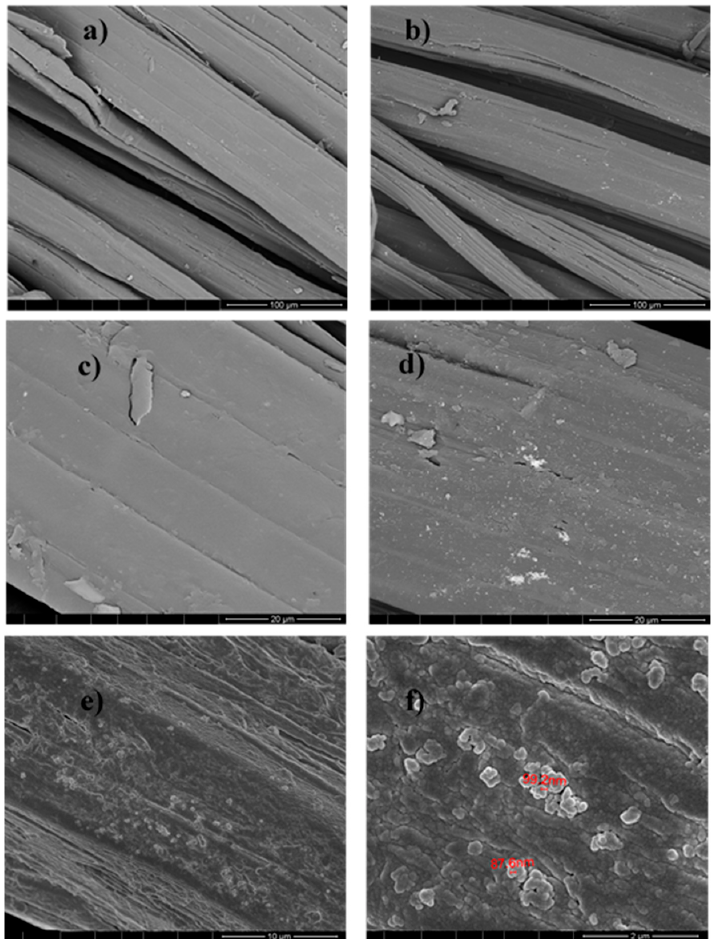
Figure 11. FESEM analysis of jute without NPs ( a , c ), and sample JUV2 ( b , d , e , f ) with different magnifications: ( b ) 100 µm, ( d ) 20 µm, ( e ) 10 µm, and ( f ) 2 µm. The ( e , f ) images are in topographic mode.